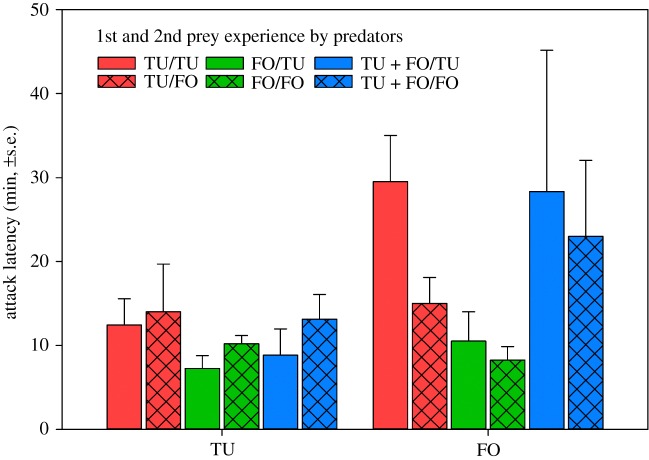
Mean attack latency on the 1st prey item by adult A. swirskii females offered a choice of six nymphs of T. urticae (TU) and six 1st larvae of F. occidentalis (FO) in the behavioural assay (experiment 1). During the preceding prey experience phase, the juvenile females received in their larval and early protonymphal stage either TU or FO or both, TU + FO, as 1st prey, and from the late protonymphal stage until adulthood either TU or FO as 2nd prey (table 1). Predators first attacking TU attacked earlier than predators first attacking FO (GLM; p < 0.001). Among predators first attacking FO, predators that had experienced FO as 1st prey in life (green bars) attacked earlier than predators that had experienced TU or TU + FO as 1st prey in life (red and blue bars) (LSD following GLM; p < 0.05).